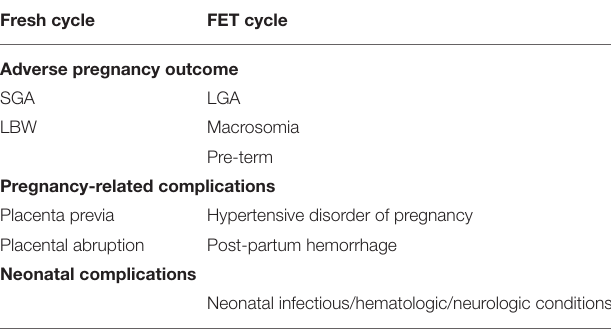
TABLE 1 | Pros and cons in fresh and FET cycles. Fresh